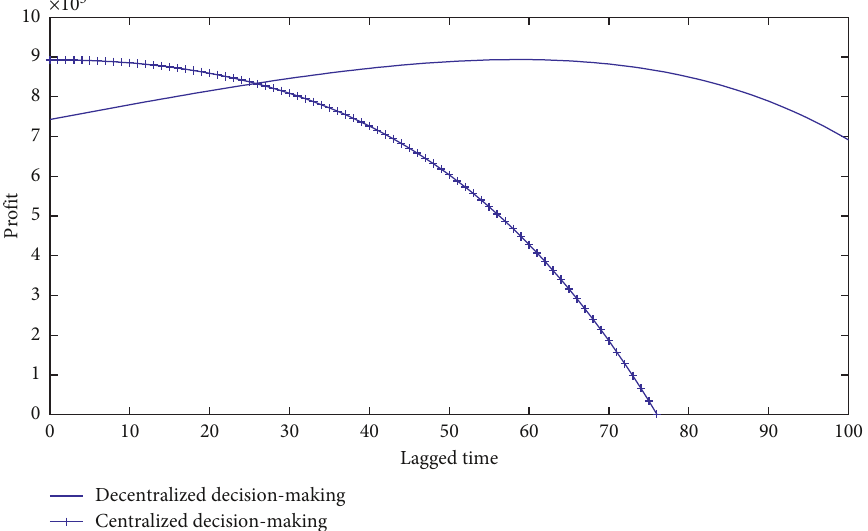
Figure 5: Impact of the lagged time on supply chain profit under decentralized and centralized